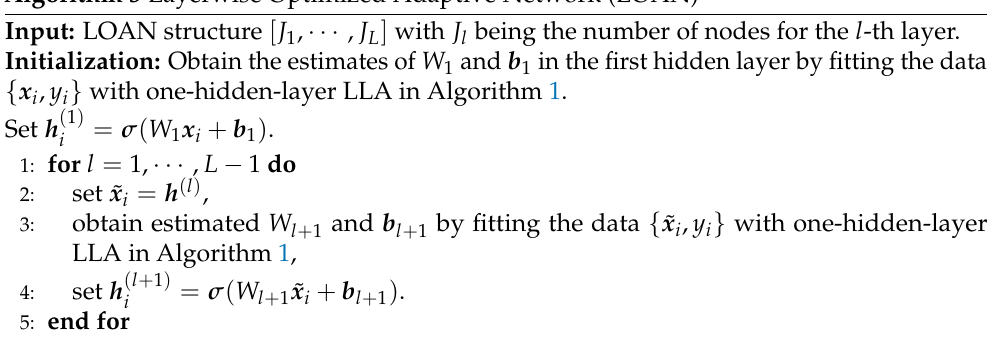
Algorithm 3 Layerwise Optimized Adaptive Network